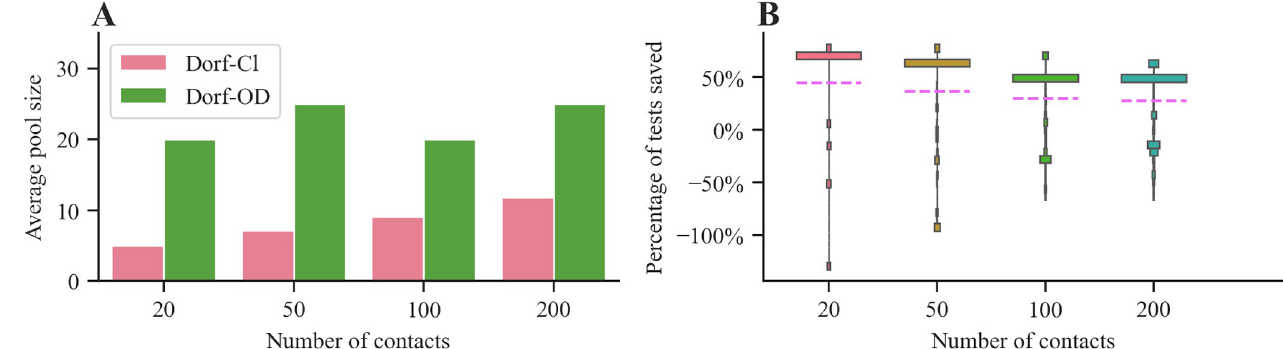
Fig 1. Performance of our method (Dorf-OD) and classic Dorfman’s method (Dorf-Cl) for various values of the number of contacts N of a diagnosed individual during their infectious period. Panel ( A ) shows the average pool size. Panel ( B ) shows the empirical distribution of the percentage of tests saved by using our method instead of Dorfman’s method, where we exclude the highest and lowest 5% of observations and the purple dashed lines represent average values. In both panels, we sample the number of secondary infections from a truncated negative binomial distribution with reproductive number R = 2.5 and dispersion parameter k = 0.1 [24] and, we set the sensitivity and specificity to s e = 0.8, s p = 0.98. For each combination of method and parameter values, the averages and quantiles in both panels are estimated using 10,000 samples.